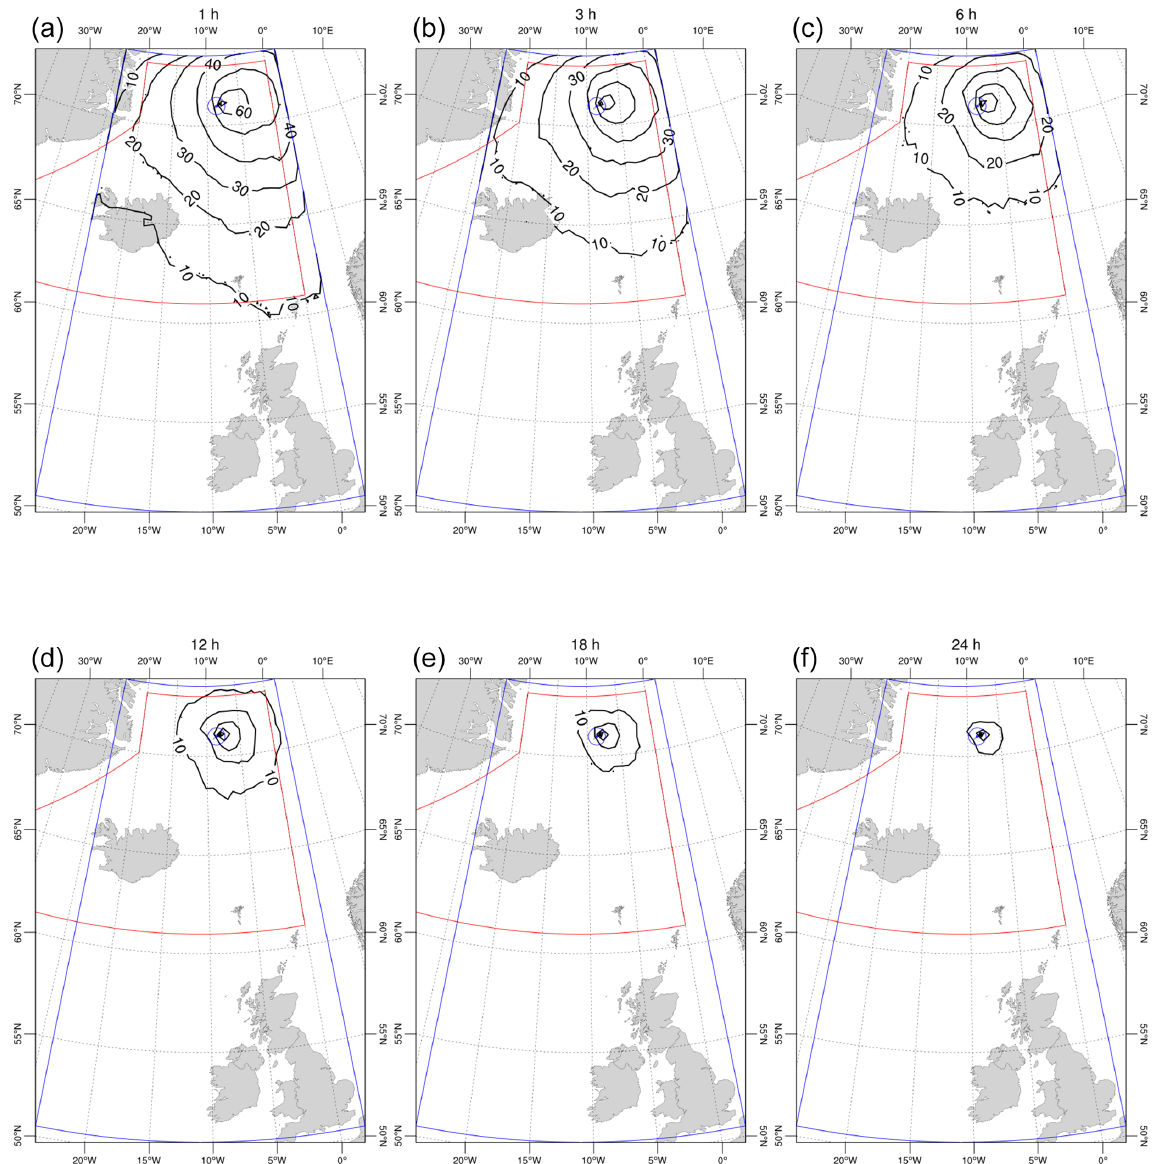
Figure 11. Persistence maps at FL050 (large class): the isolines show the probability of reaching or exceeding an ash concentration above 2mgm − 3 at FL050 for 1, 3, 6, 12, 18, and 24h during the eruption to up to 48h after its